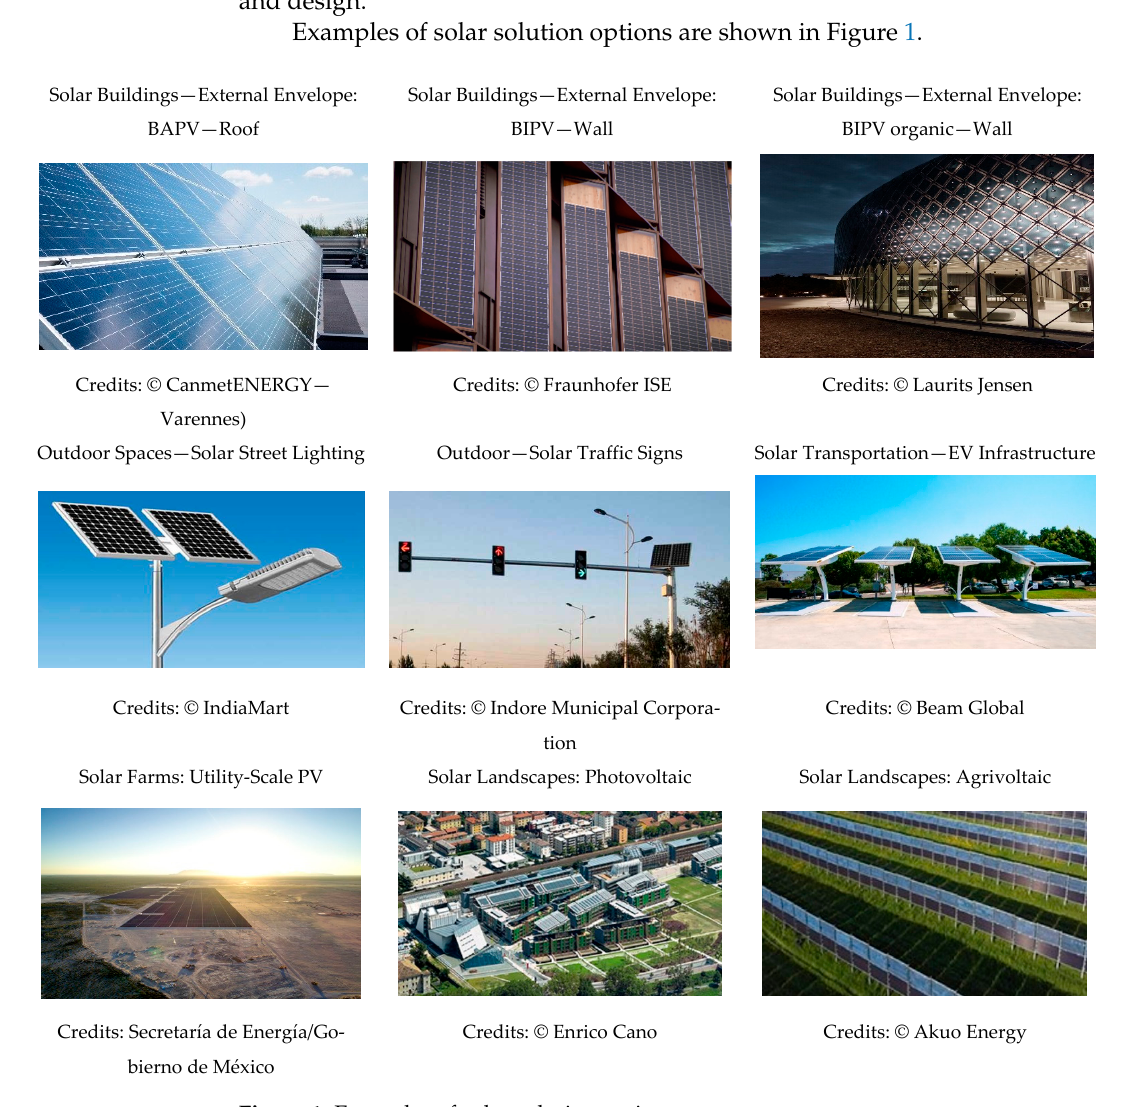
Figure 1. Examples of solar solution options.